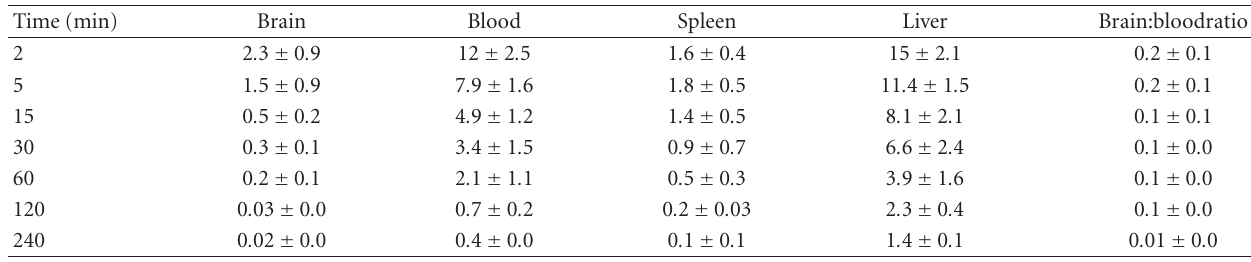
Table 2: In vivo biodistribution of 125 I-CQ-BCA-NPs by IV administration in wild type mice ( n = 105) (NP polymerized in the presence of 1% Dextran 70000 and 1% Tween-80; the table represents organ uptakes in %ID/g ± SD).